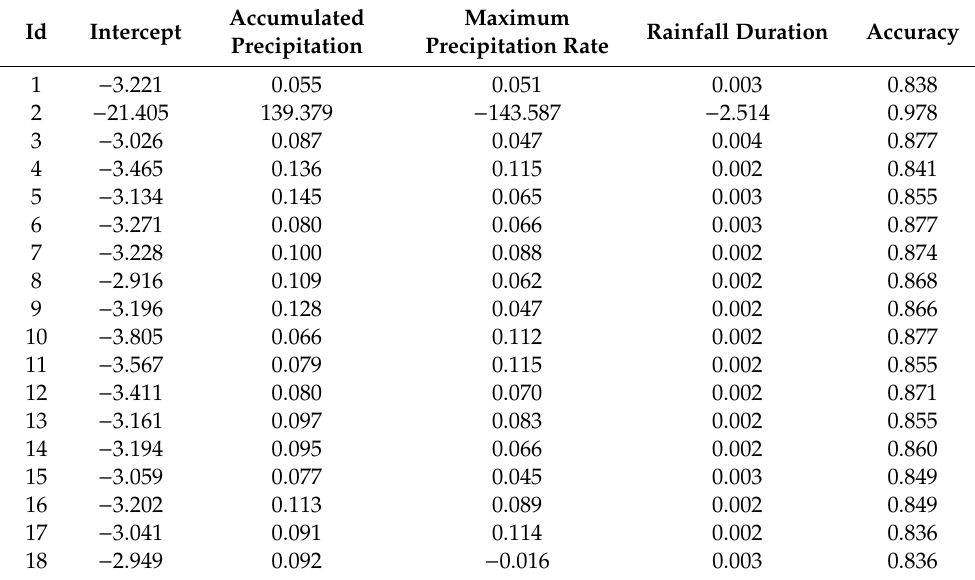
Table A1. Logistic regression model coe ffi cients for the three variables included.